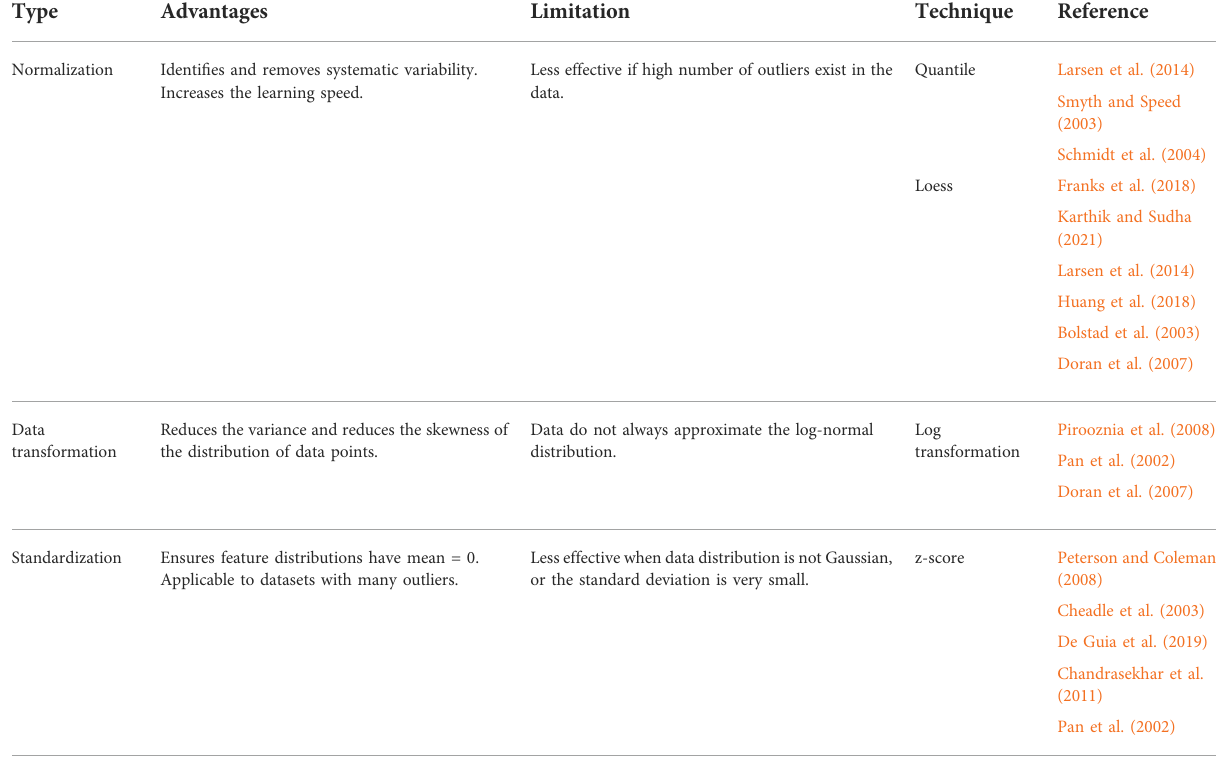
TABLE 3 List of data transformation and feature scaling techniques prior to dimensionality